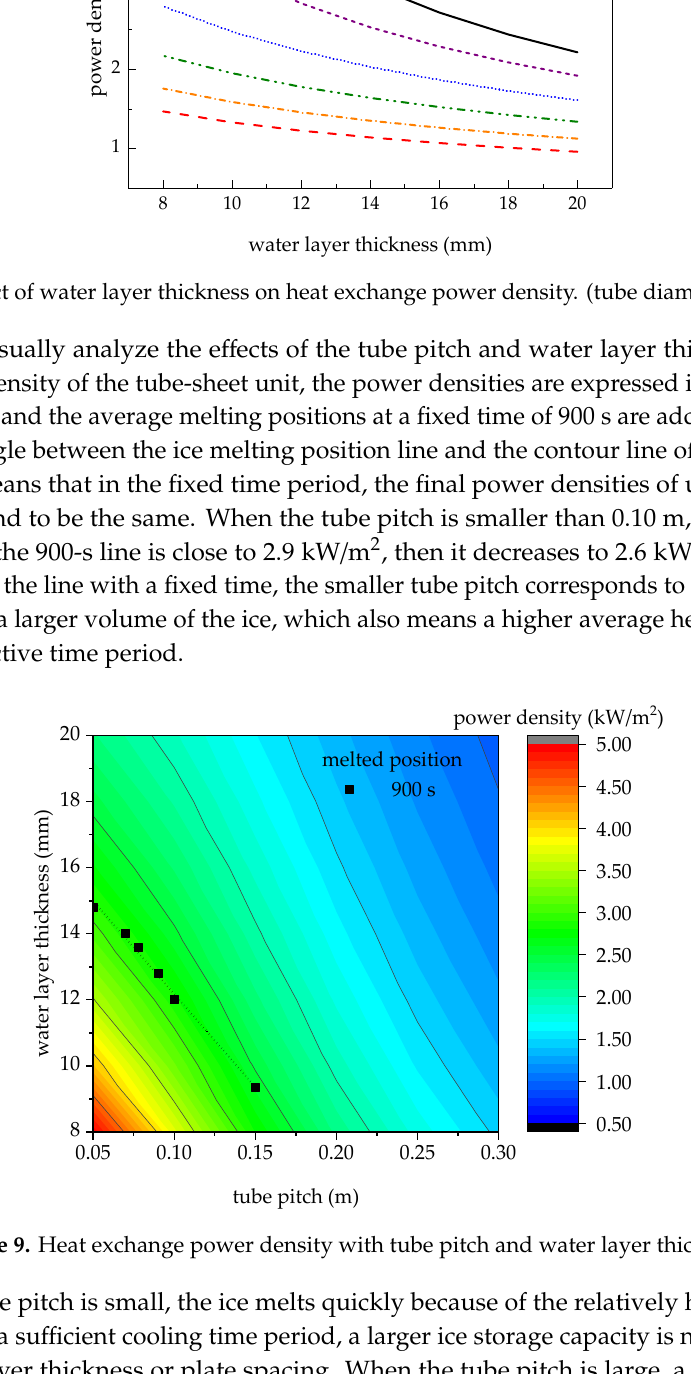
Figure 7. Effect of tube pitch on heat exchange power density. ( a ) water layer thickness = 20 mm. ( b ) tube diameter = 10 mm.